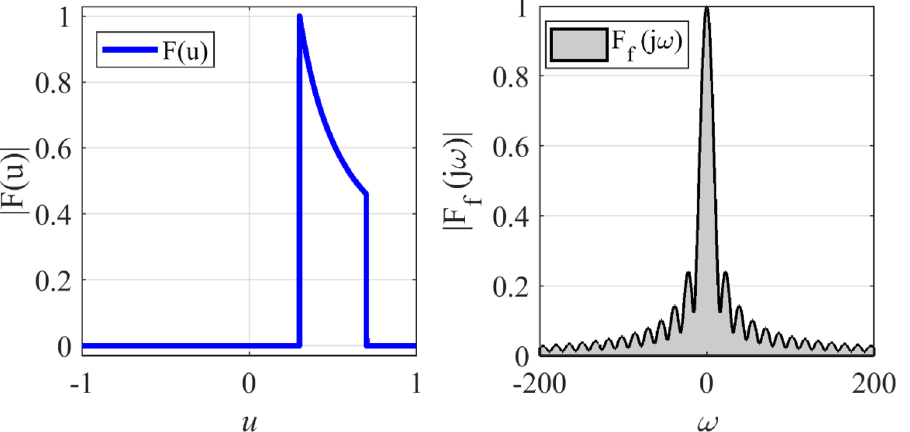
Figure 8. The desired pattern of the third case and its Fourier transform.